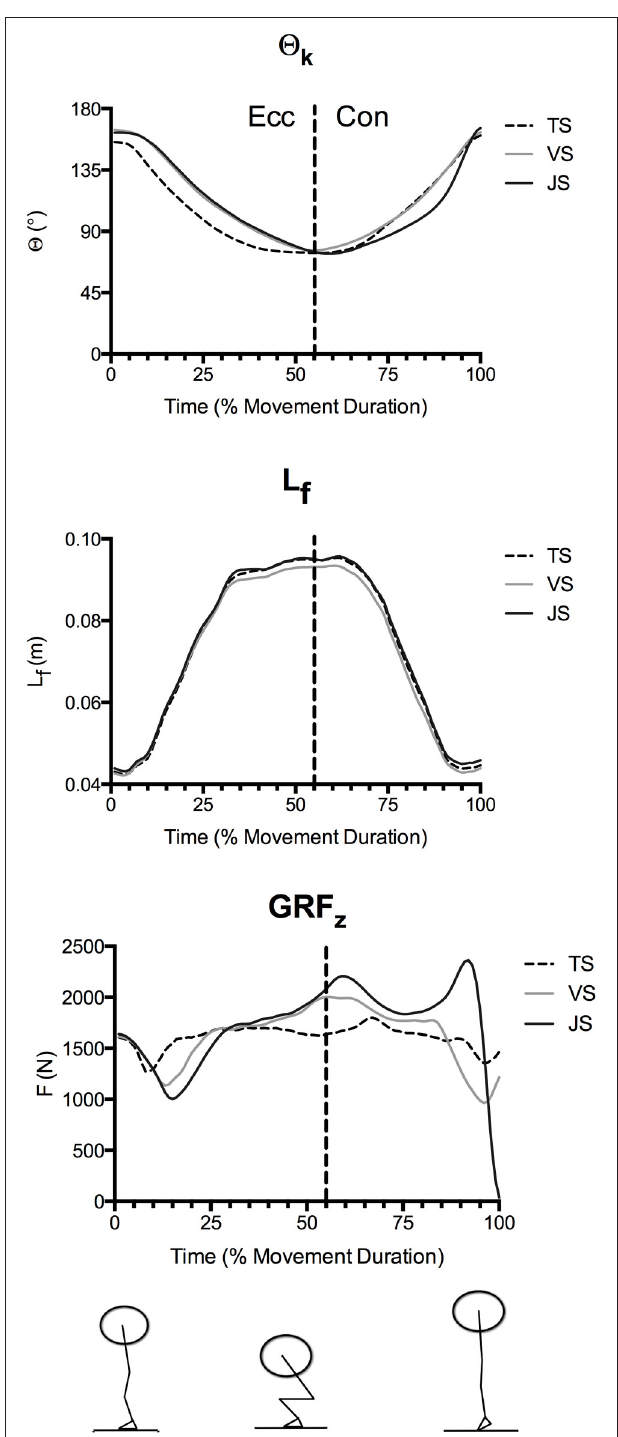
FIGURE 2 | Mean knee angle ( 2 k ), fascicle length (L f ), and vertical ground reaction forces (GRF z ) during parallel-depth slow-tempo (TS), volitional speed (VS), and jump (JS) squat conditions ( n = 10). Peak knee flexion occurred at 53.7 ± 6.1, 55.9 ± 4.9, and 59.3 ± 4.6% movement duration for TS, VS, and JS, respectively. Range of SEM at 20, 40, 60, 80, and 100% movement duration for 2 k (0.12 ◦ − 0.33 ◦ ), L f (0.46–1.87cm) and GRF z (140–487 N) are